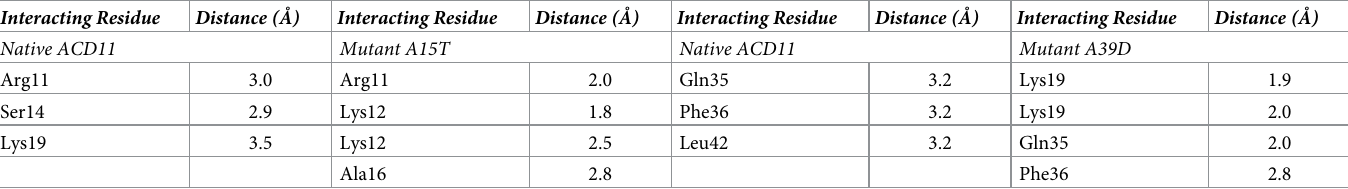
Table 1. Intramolecular interactions between native and mutant protein structure ( Å = 10 -10